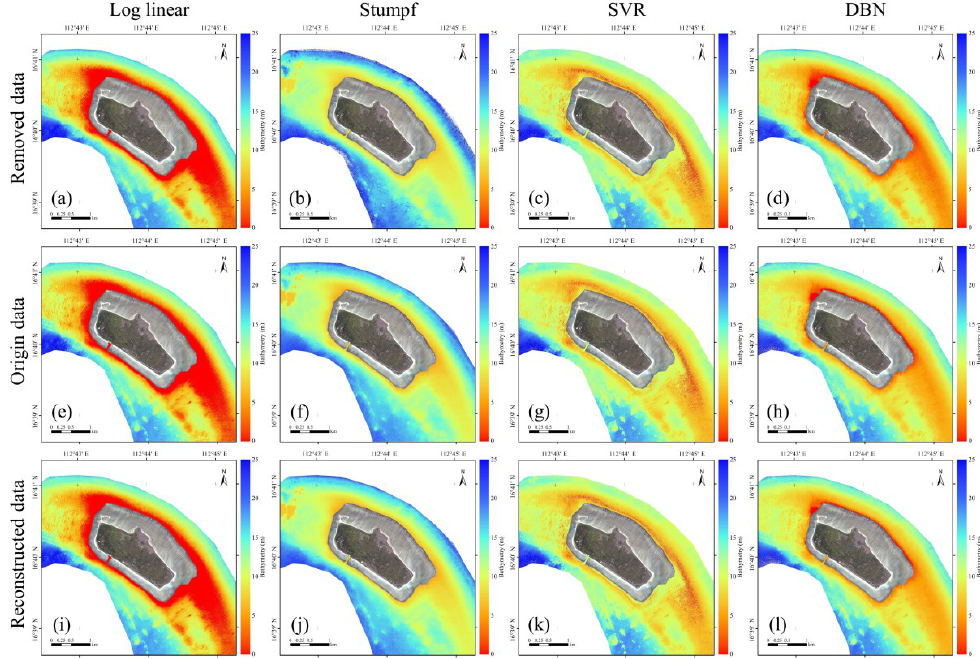
Figure 7. Shallow-water bathymetric maps derived from four models with three groups of data in the Dongdao Island study area. ( a – d ) Bathymetric maps derived from four models based on data with manual removal; ( e – h ) Bathymetric maps derived from four models based on origin data; ( i – l ) Bathymetric maps derived from four models based on reconstructed data.